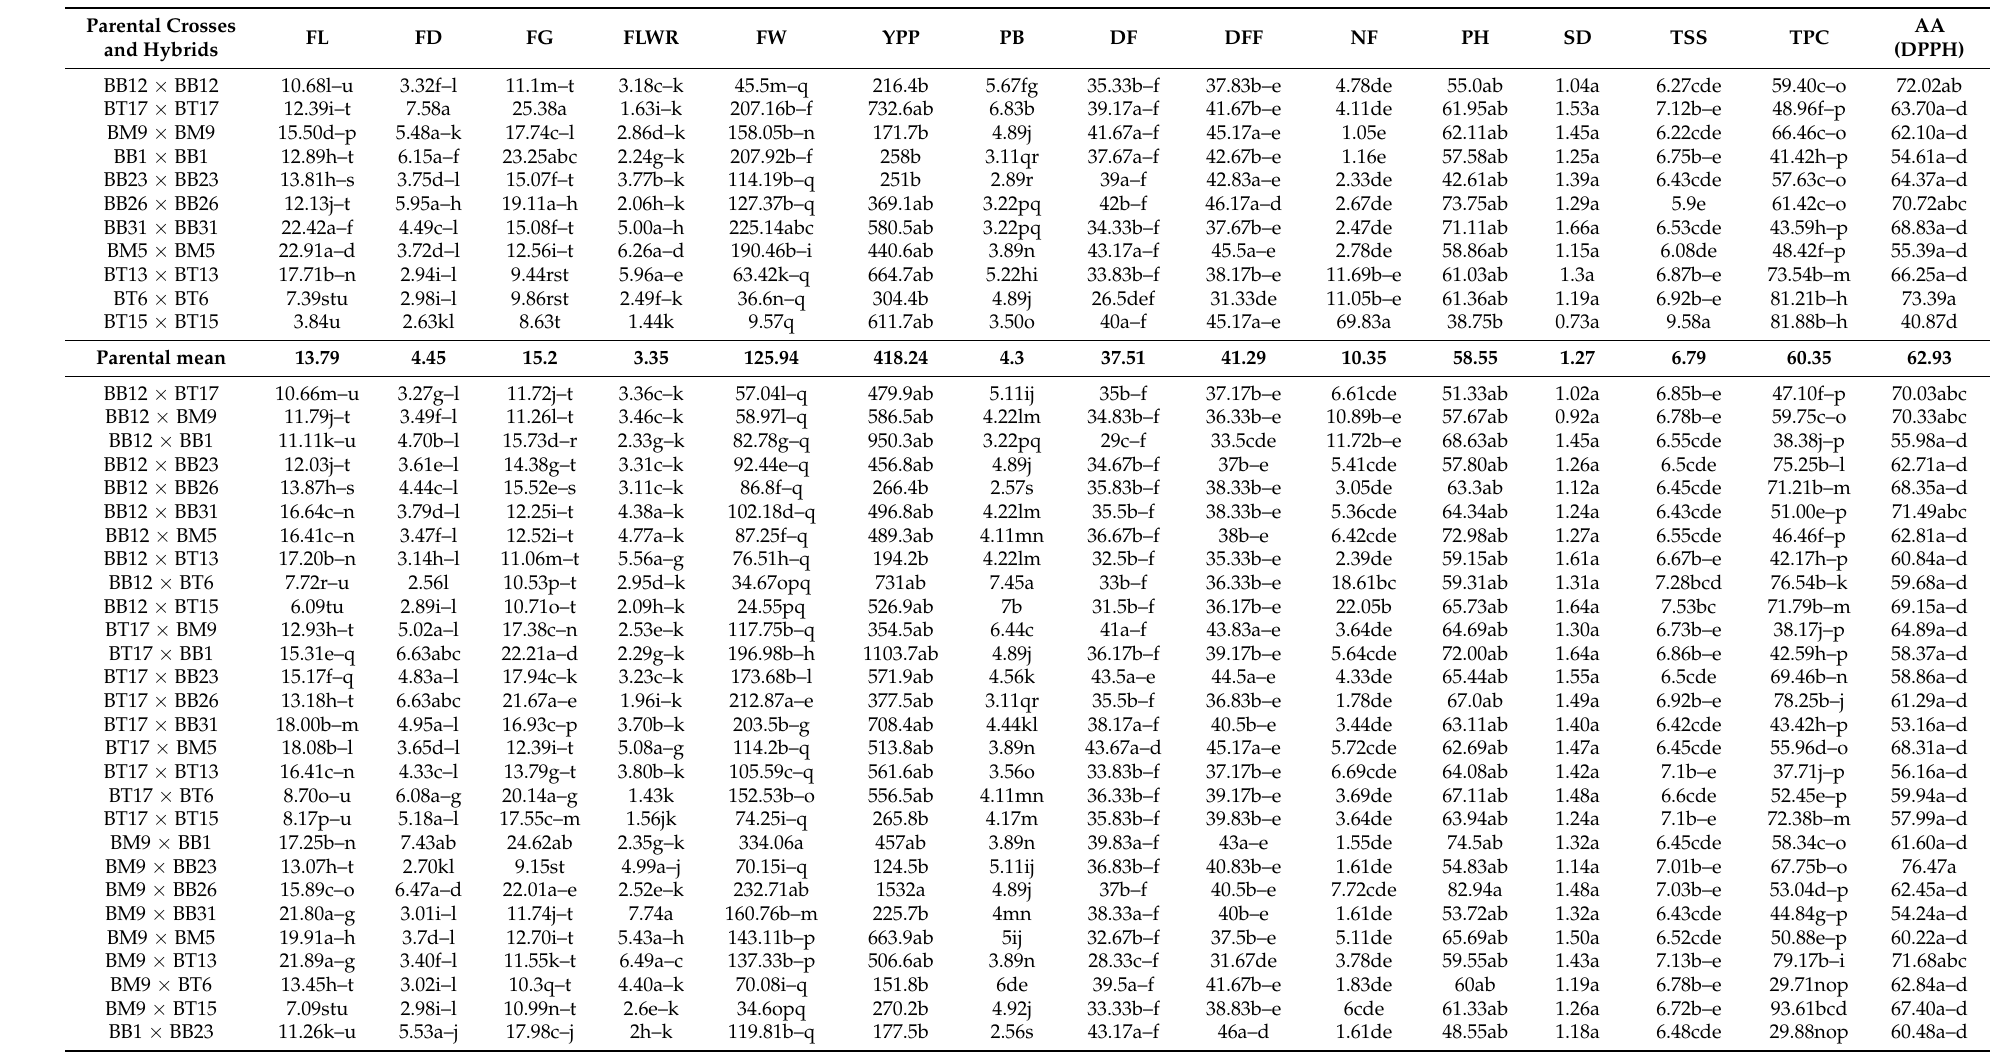
Table 5. Means for quantitative characters studied in 66 eggplants in two